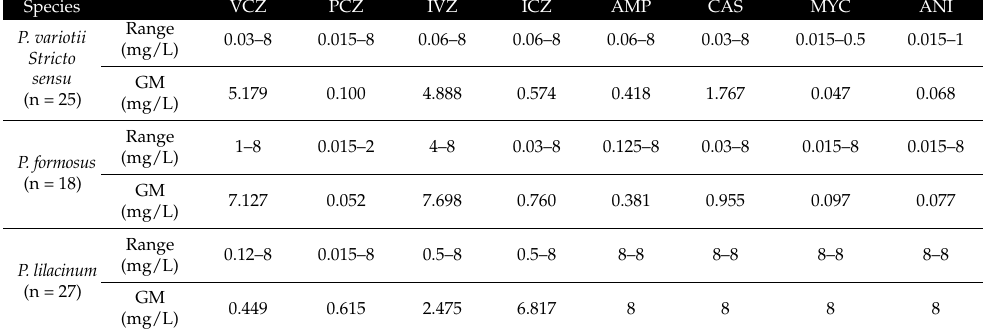
Table 1. Susceptibility of Paecilomyces isolates to antifungals by